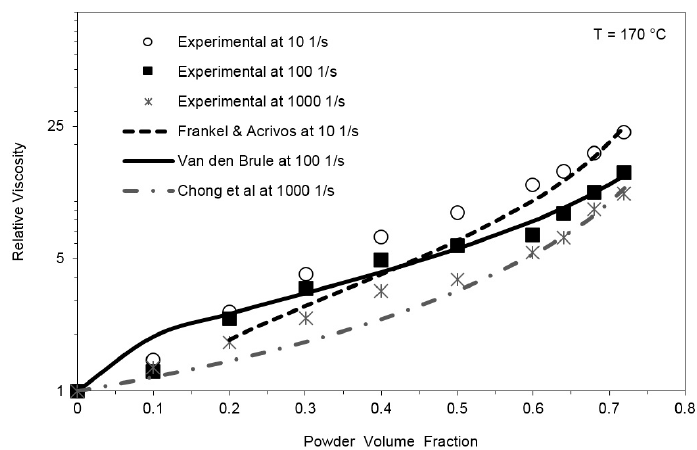
Figure 6. Relative viscosity as a function of powder loading for PP ‐ based feedstock at 170 °C. Lines represent the fittings done by the model proposed by Frankel et al. Please note that the vertical axis is in logarithmic scale.